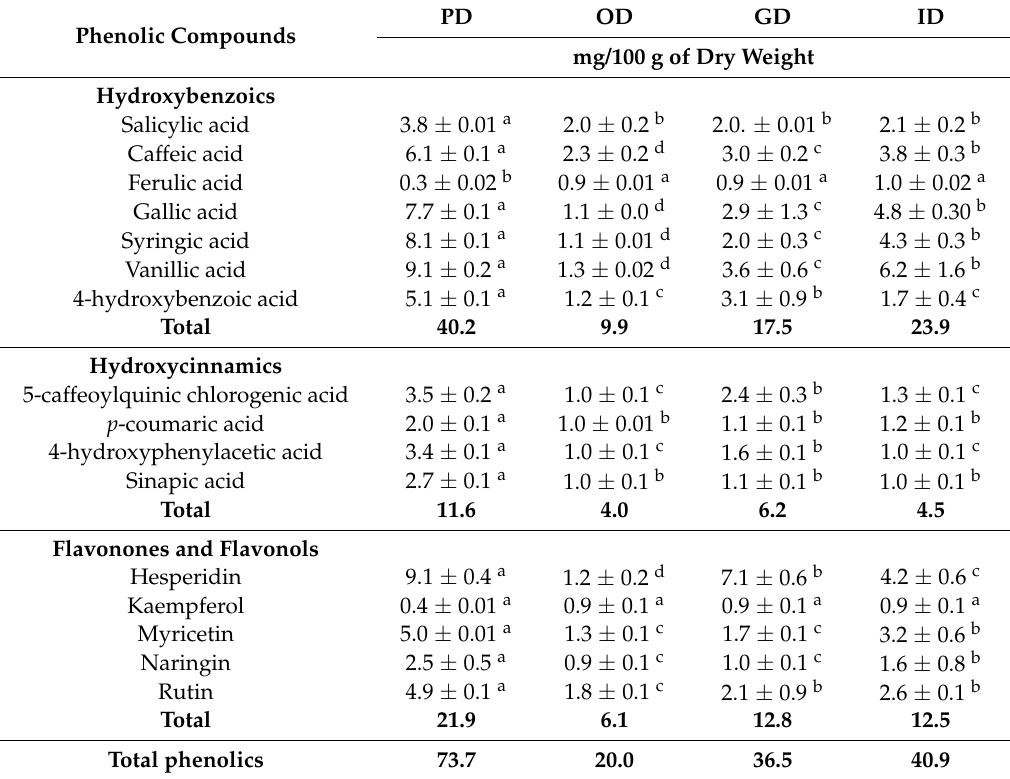
Table 2. Bioaccessibility of phenolics from soybean meal aqueous